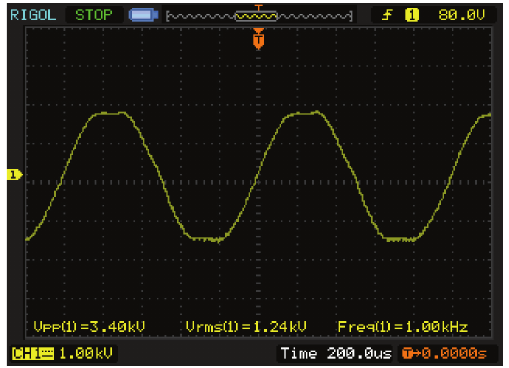
Figure 7: High-voltage output waveform of clipping with THD = 10% (1kV/div, 200 us/div).